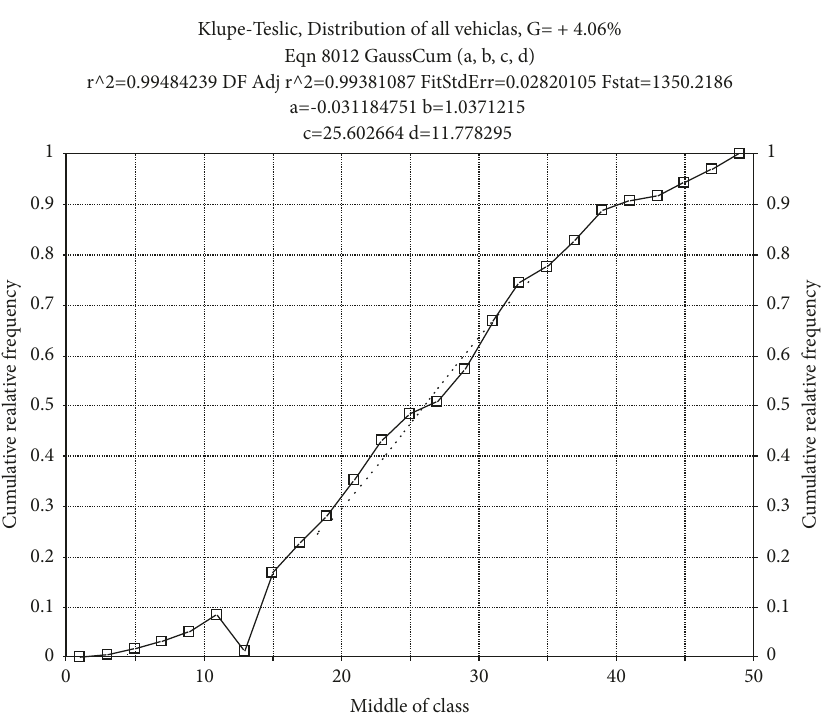
Figure 3: Example of cumulative relative frequency of obtained values of speed deviation from the speed limit for all vehicles in traffic flow. gradient is slightly lower than that for PV and ranges from deviation for PV is balanced on flat terrain, but progressively 7.417 km/h ≤ Δ V ≤ 15.316 km/h. The highest deviation from increasing on the descent. This shows a large dispersion of the speed limit on the ascent for PV occurs on the measuring speeds on individual measuring sections for PV. For LDV, section of a gradient G � +4.06%. Significantly lower the dispersion of speed deviations towards the longitudinal